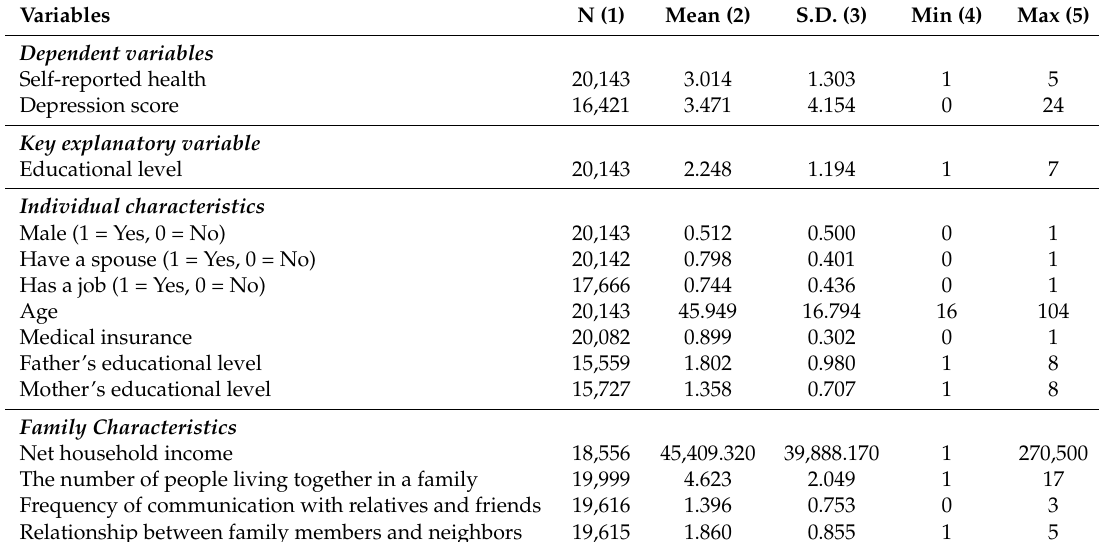
Table 1. Descriptive statistics of